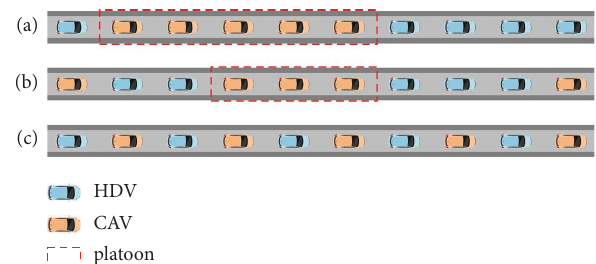
Figure 1: Illustration of vehicle distribution states in mixed trafc fow ( p � 0 .